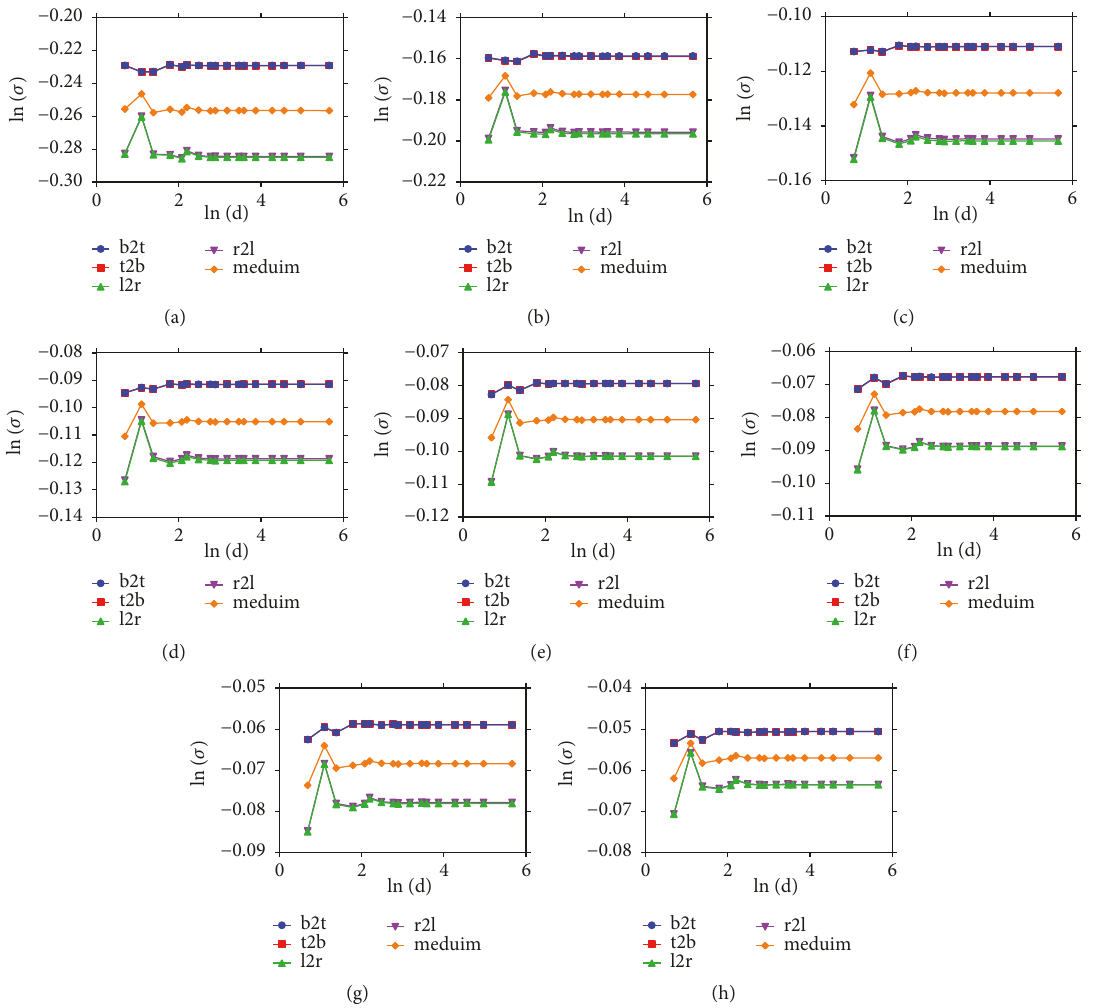
Figure 9: Logarithmic scatter plots of Succolarity values a function of the corresponding dividing factor d using as input the images in Figure 5. (a) (cid:2) 200Ω. m . (b) (cid:2) 220Ω. m . (c) (cid:2) 240Ω. m . (d) (cid:2) 260Ω. m . (e) (cid:2) 280Ω. m . (f) (cid:2) 300Ω. m . (g) (cid:2) 320Ω. m . (h) (cid:2) 340Ω. m .